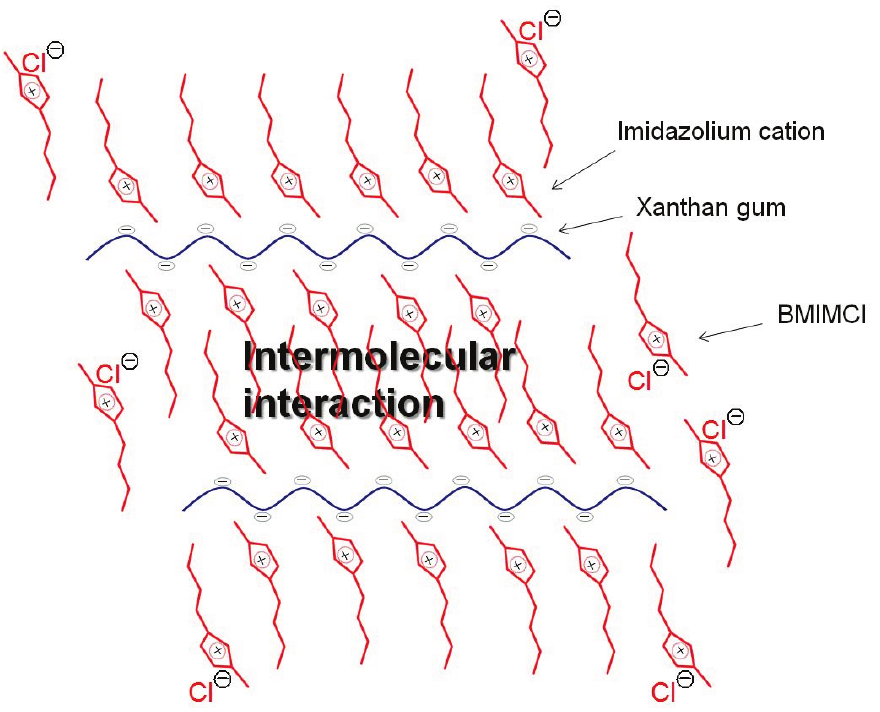
Figure 11. Plausible associate structure of xanthan gum and BMIMCl in ion